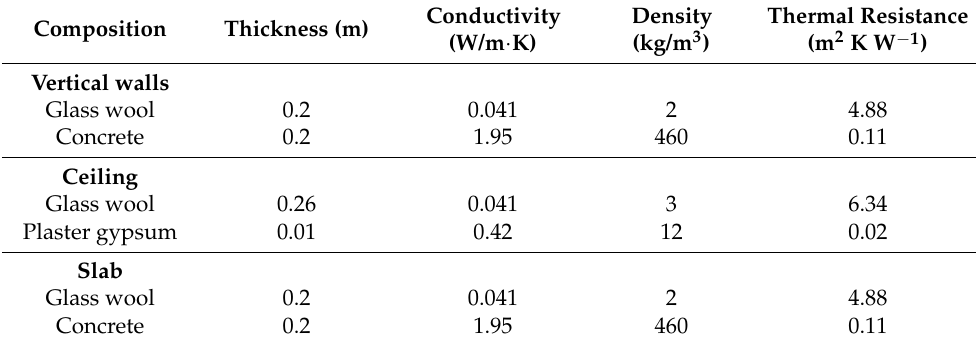
Table 3. The composition of the walls, roof, and slab.